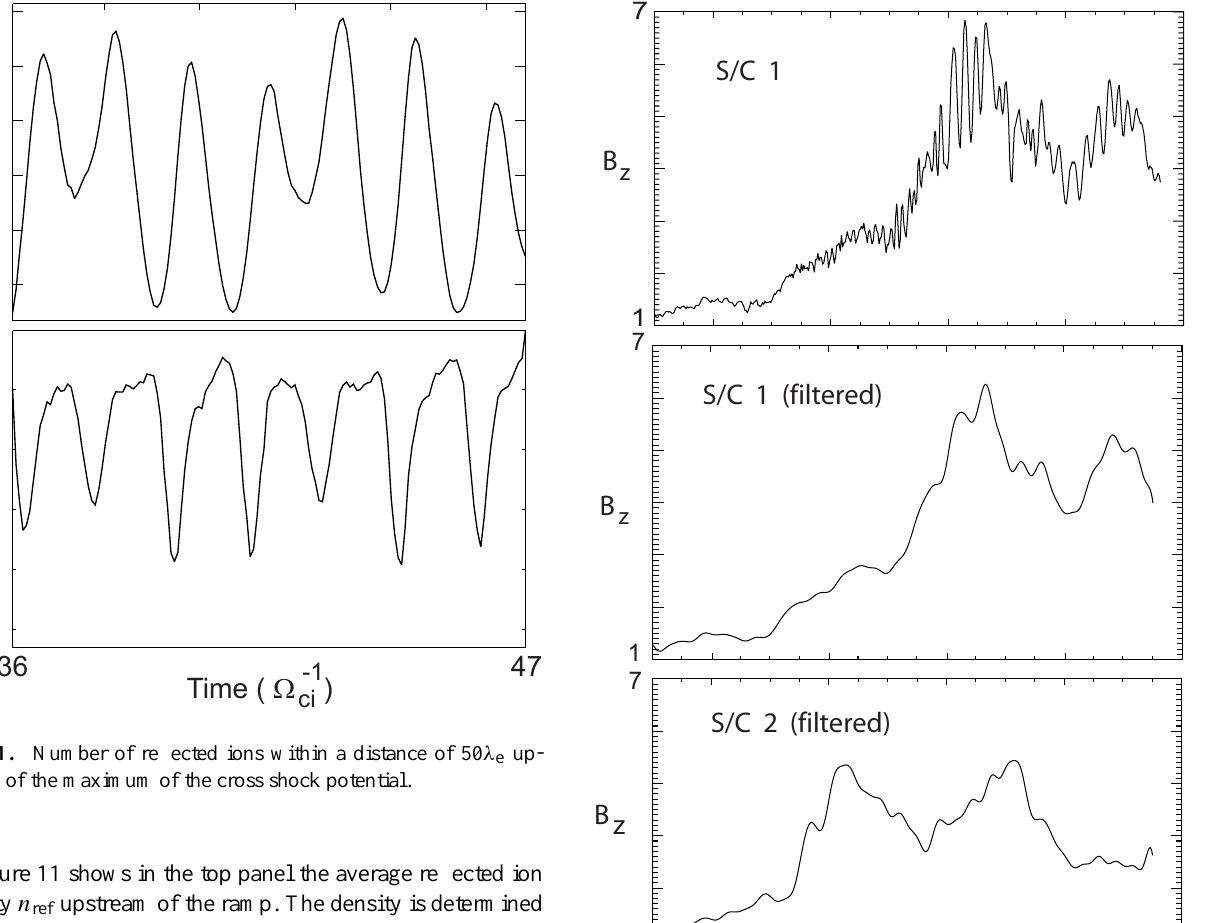
Fig. 11. Number of reflected ions within a distance of 50 λ e upstream of the maximum of the cross shock potential.